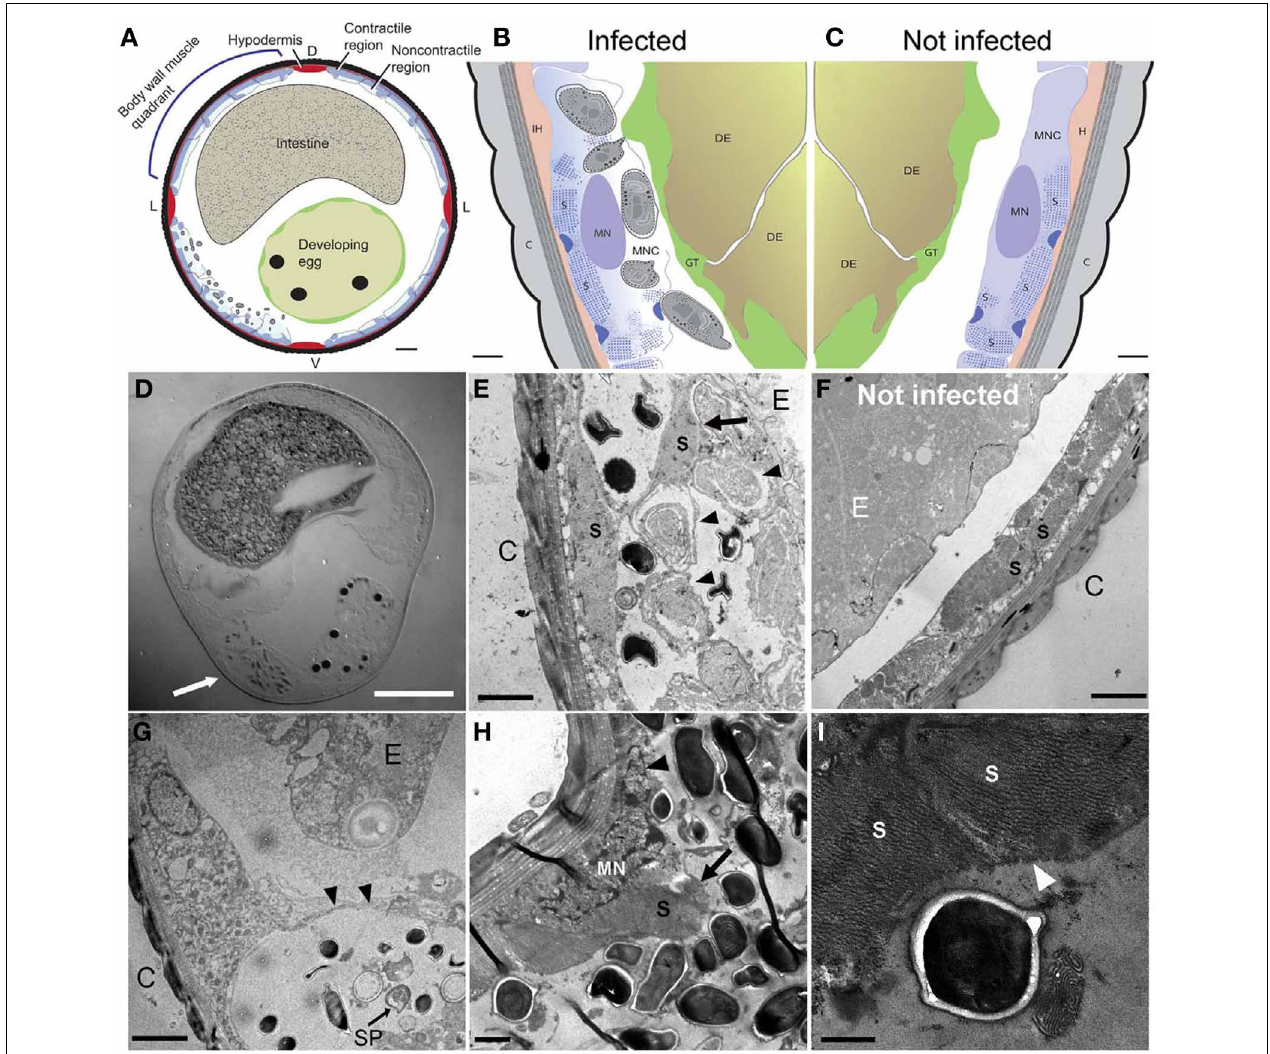
FIGURE 4 | N. marisprofundi infection induces host muscle decomposition. (A–C) Diagrams based on many TEM micrographs integrated to show body wall muscle decomposition by N. marisprofundi . C, cuticle; H, hypodermis; S, sarcomeres; MN, muscle nucleus; GT, genital tract, DE developing egg, MNC muscle non-contractile region. Microsporidia spores are represented by gray ovals. (D) A Nomarski DIC transverse section of an infected female harboring spores (arrow). (E,F) TEM micrographs of infected (E) and